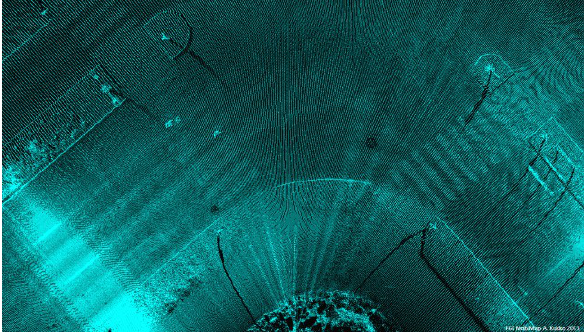
Figure 2. Vehicle MLS data from a street corner captures geometry of the streets, road paintings and other road environment structures in high